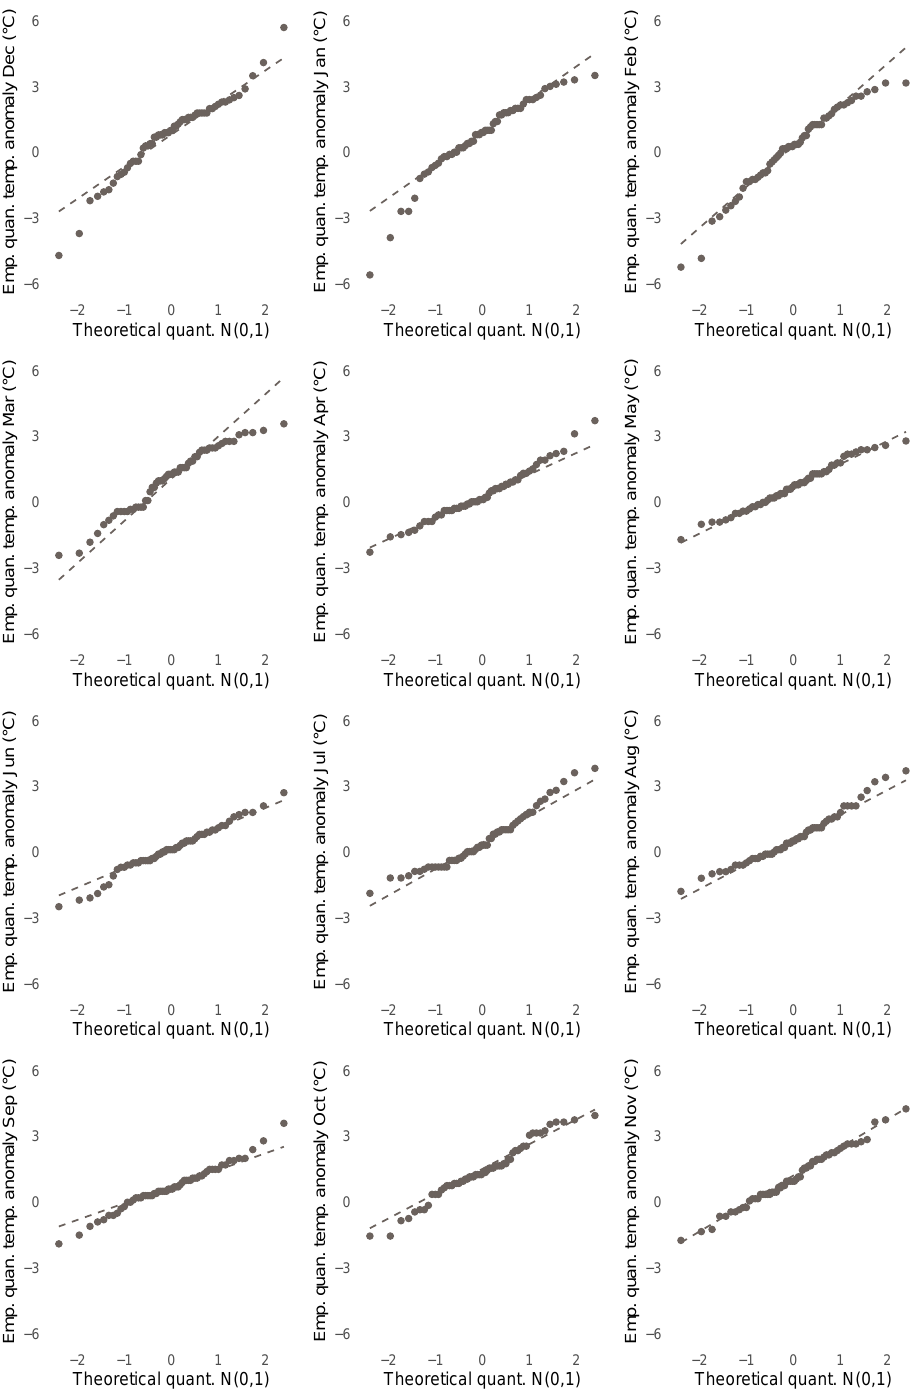
Figure 8. Sample quantiles of anomalies for each month from January 1961 until December 2020 (ordinate) and theoretical quantiles of standard normal distribution (abscissa). Dashed grey line connects points constituted of respective 0.25%- and